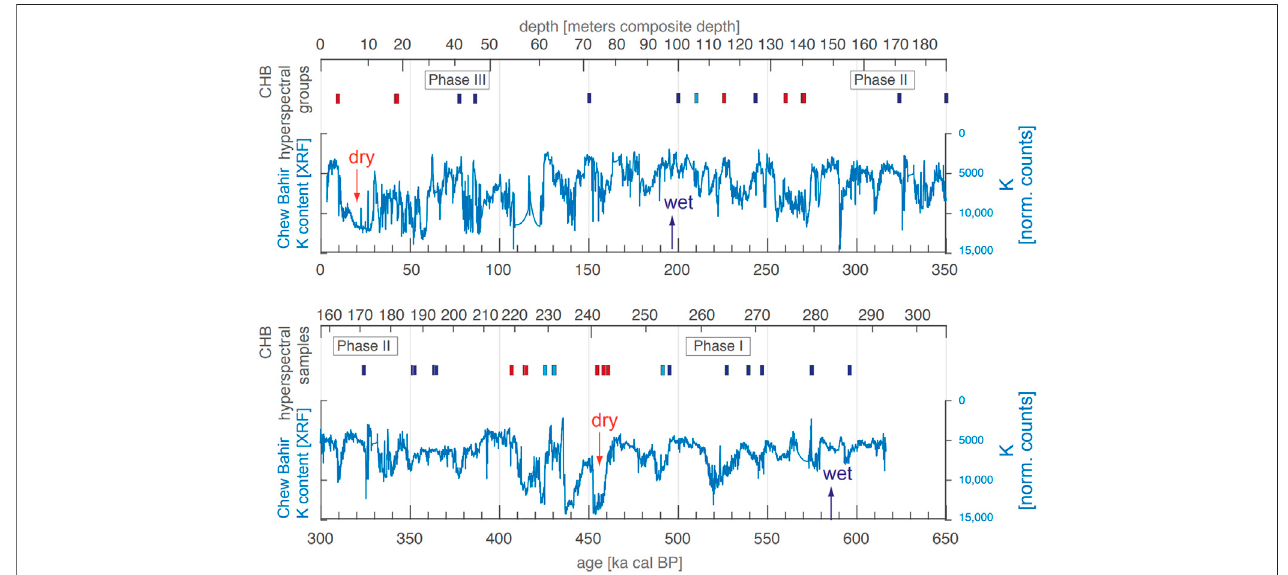
FIGURE 2 | Variation in the potassium (K) content of the composite CHB14-2 core from the Chew Bahir Basin (in normalized counts per second) (Trauth et al., 2020)plottedagainstage(Robertsetal.,submitted)andcoredepth.ThepotassiumcontentisanestablishedaridityproxyfortheCHBsediments(Foersteretal.,2018). The bars and the phases refer to the results of the hyperspectral analyses as discussed in “ Conclusion ” section (red: dry-climate sediment; light blue: wet-to-dry- transition-climate sediment; blue: wet-climate